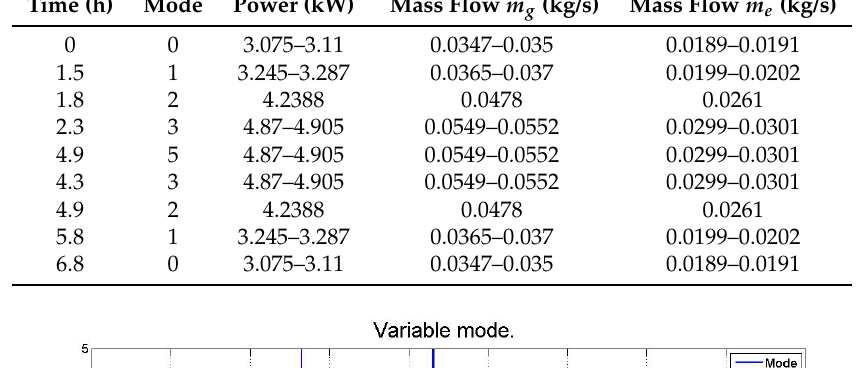
Table 5. Different modes of operation varying in time for radiation of 900 kW/m 2 .